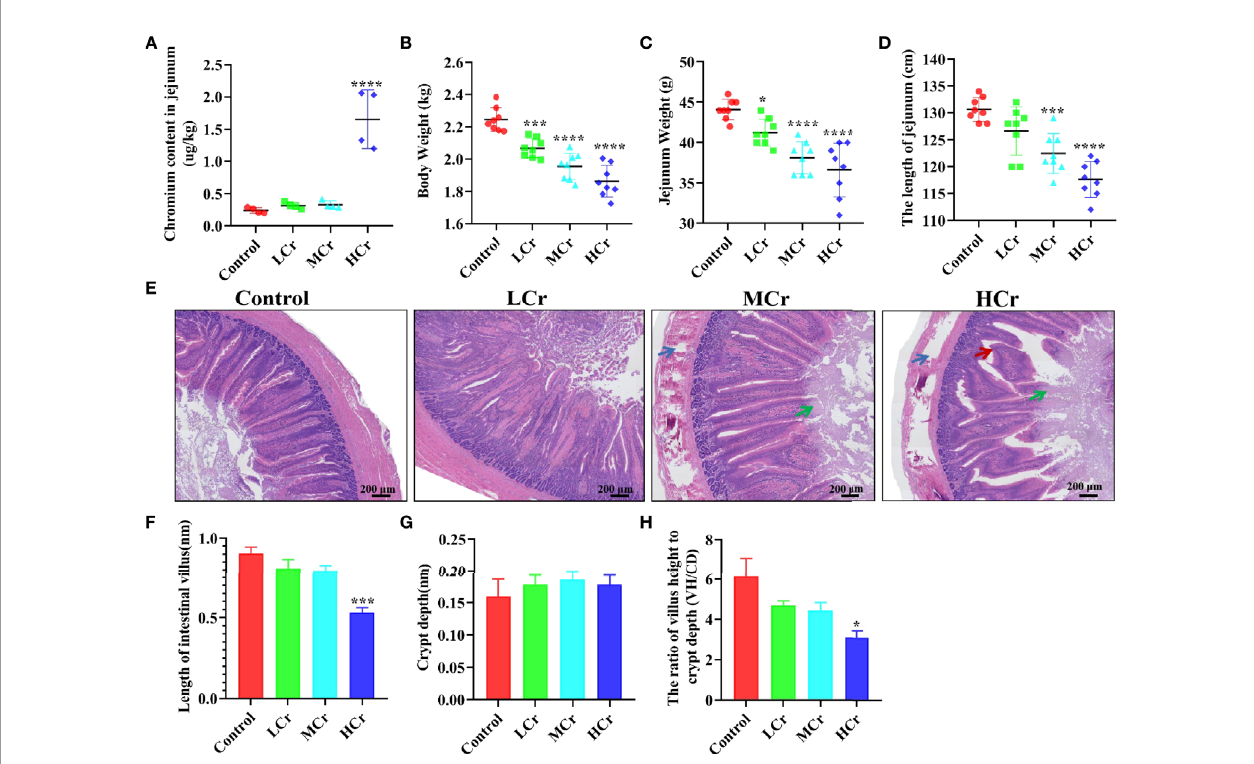
FIGURE 1 | Cr(VI) exposure induced intestinal damage. (A) Cr(VI) content in jejunum tissues. (B) Body weight. (C) Jejunum weight. (D) The length of jejunum. (E) Histopathological variation in jejunum tissues (scale bar = 200 m m). (F) Length of intestinal villus. (G) Crypt depth. (H) The ratio of villus height to crypt depth (VH/CD). All data were presented as mean ± SEM; n ≥ 3 for each group. The symbol “ * ” denotes a statistically signi fi cant difference from the control group (* P < 0.05, *** P < 0.005 and **** P <